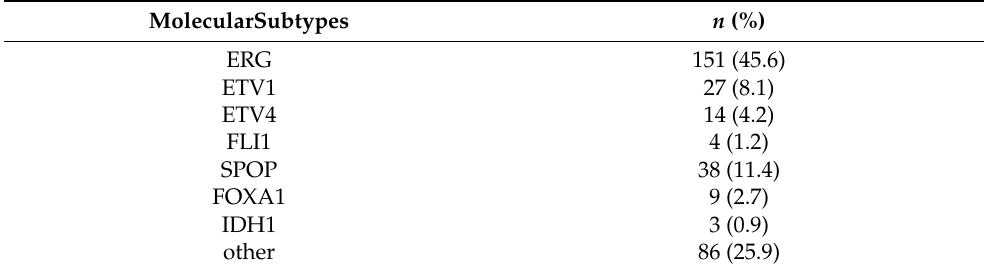
Table 1. Distribution of the molecular subtypes in the TCGA-PRAD